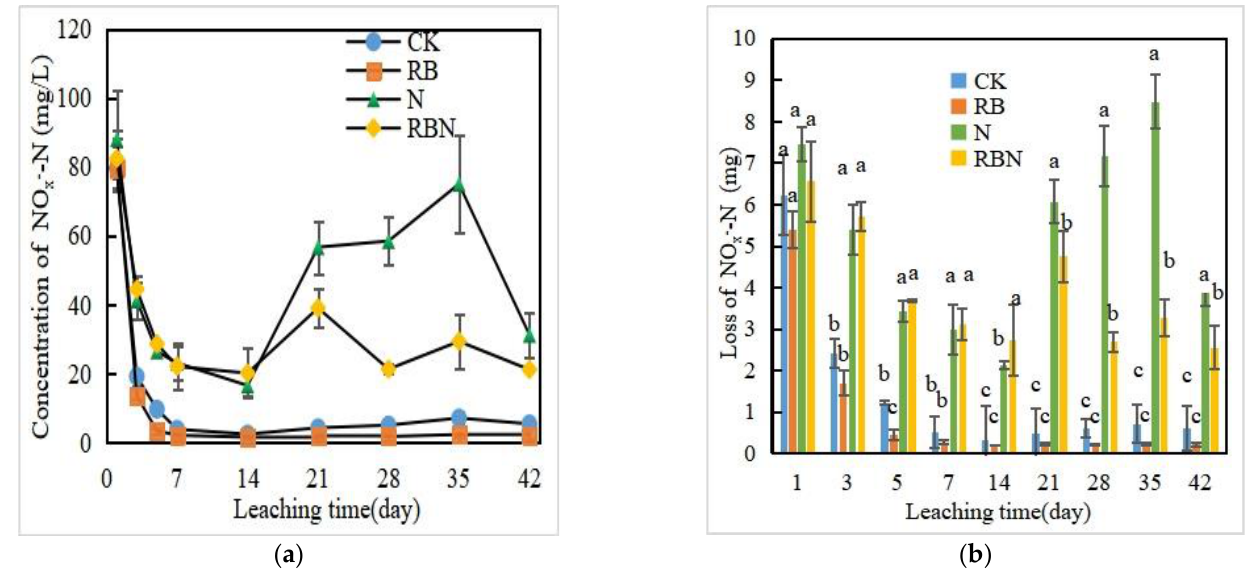
Figure 3. ( a ) Concentration of NO x − -N in leachate; ( b ) loss of NO x − -N in leachate. Different letters in the image ( b ) indicate significant differences between treatments ( p < 0.05).